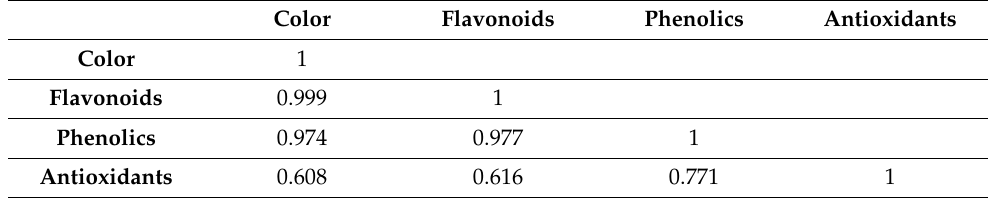
Table 15. Correlation established between the color, flavonoids, phenolics and antioxidants [90].